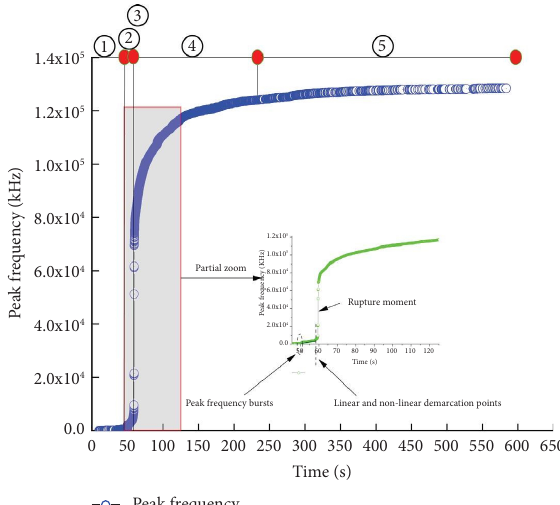
Figure 6: Variation curve of acoustic emission cumulative ringing count in the whole loading process.